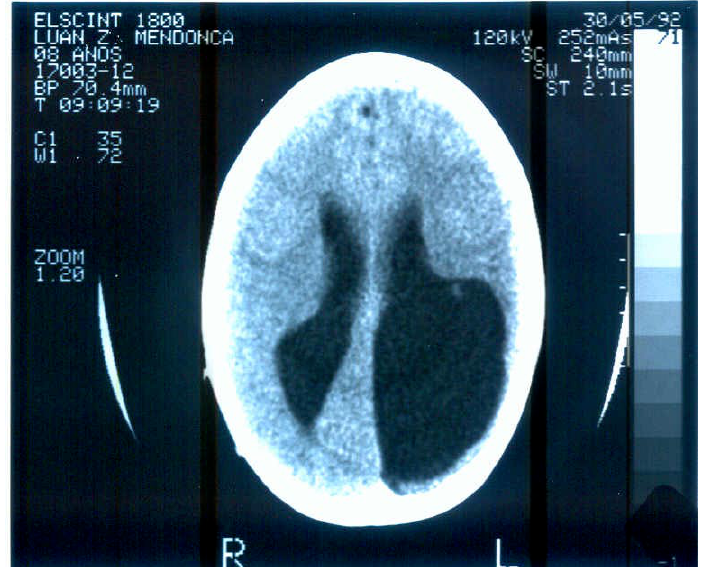
Figura 4. Ressonância magnética